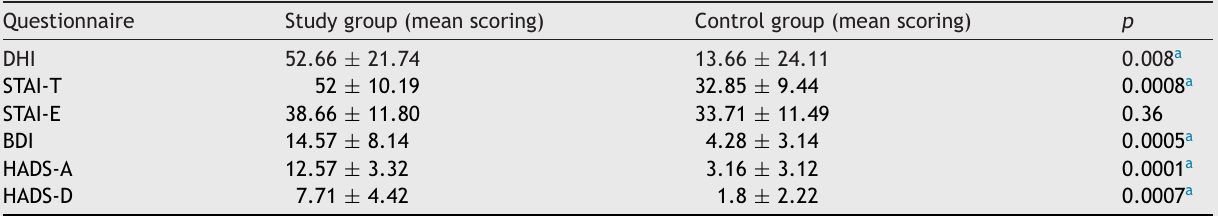
Responses to questionnaires formulated for patients with chronic subjective dizziness (study group) and patients who